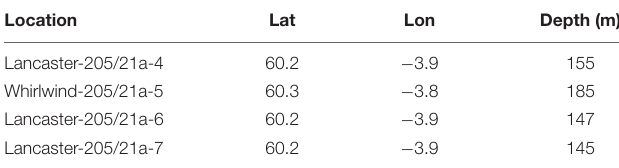
TABLE 1 | Location of well sites used in this